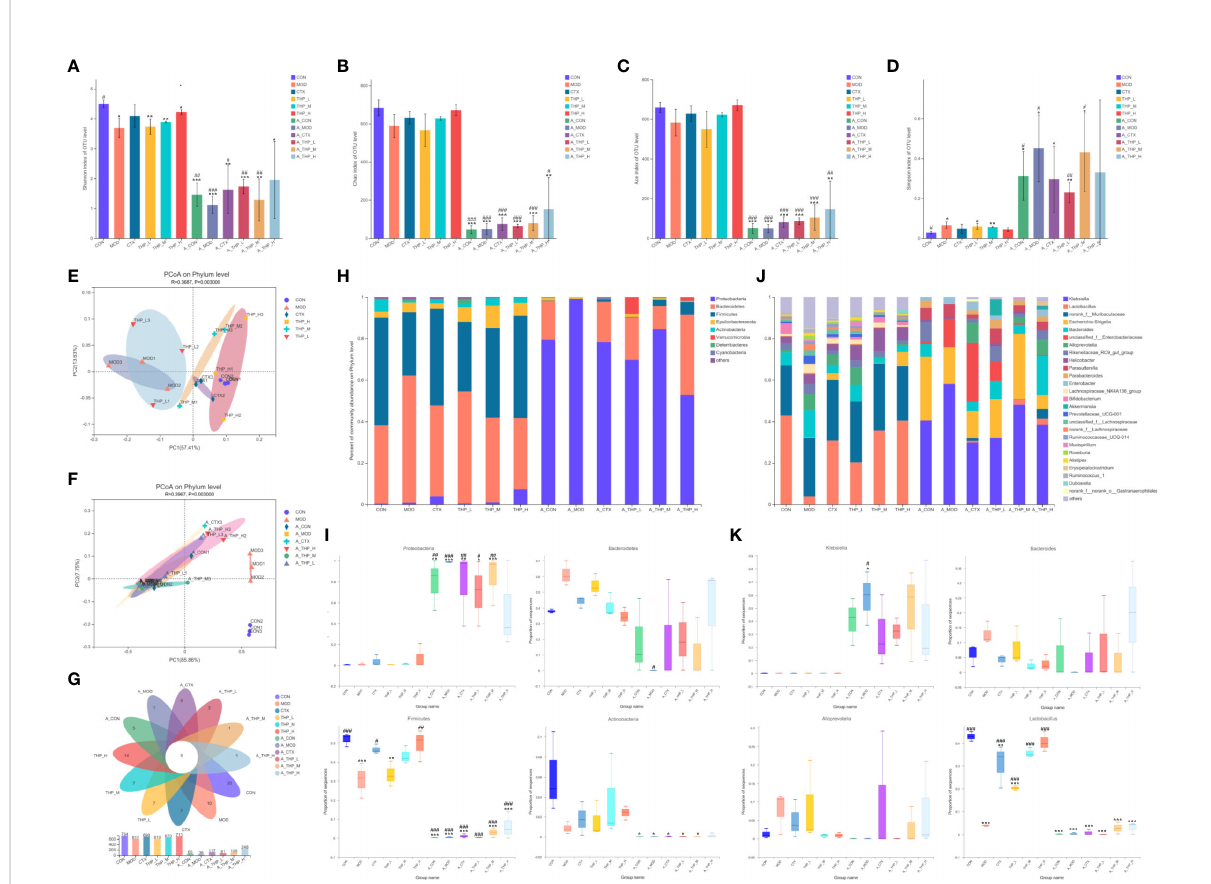
FIGURE 3 THP alters the abundance and diversity of intestinal fl ora. (A) Simpson indices. (B) Ace indices. (C) Chao indices. (D) Shannon indices. (E, F) PCoA at the phylum level. (G) Venn diagram. (H) Relative abundance of microbiota at the phylum level. (I) Characteristic bacteria at the phylum level. (J) Relative abundance of microbiota at the genus level. (K) Characteristic bacteria at the genus level. Each value is presented as the mean ± SD. *P < 0.05, **P < 0.01, ***P < 0.001 versus CON; # P < 0.05, ## P < 0.01, ### P < 0.001 versus